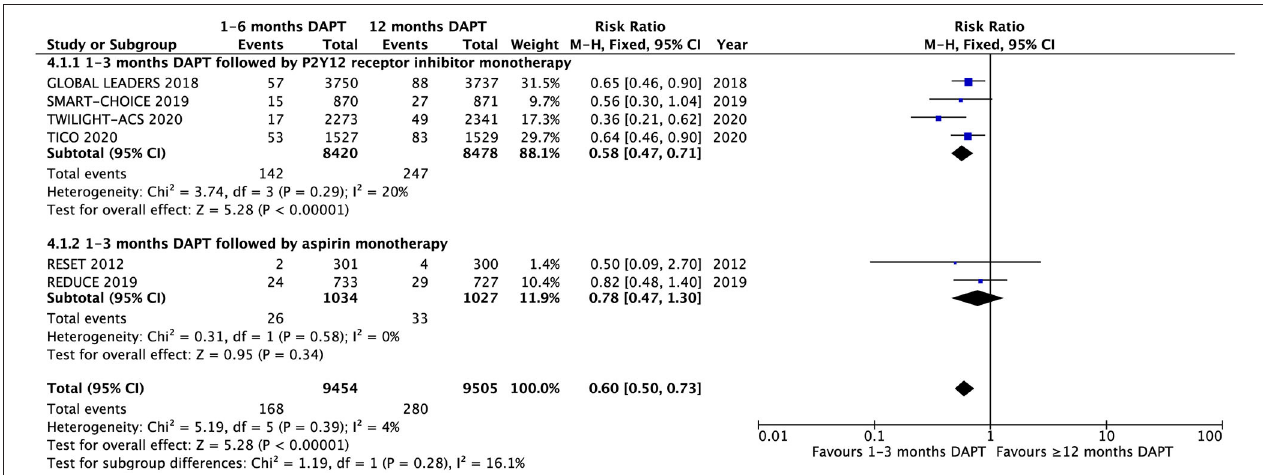
FIGURE 3 | Subgroup analysis of major bleeding between groups with short-term and long-term DAPT.